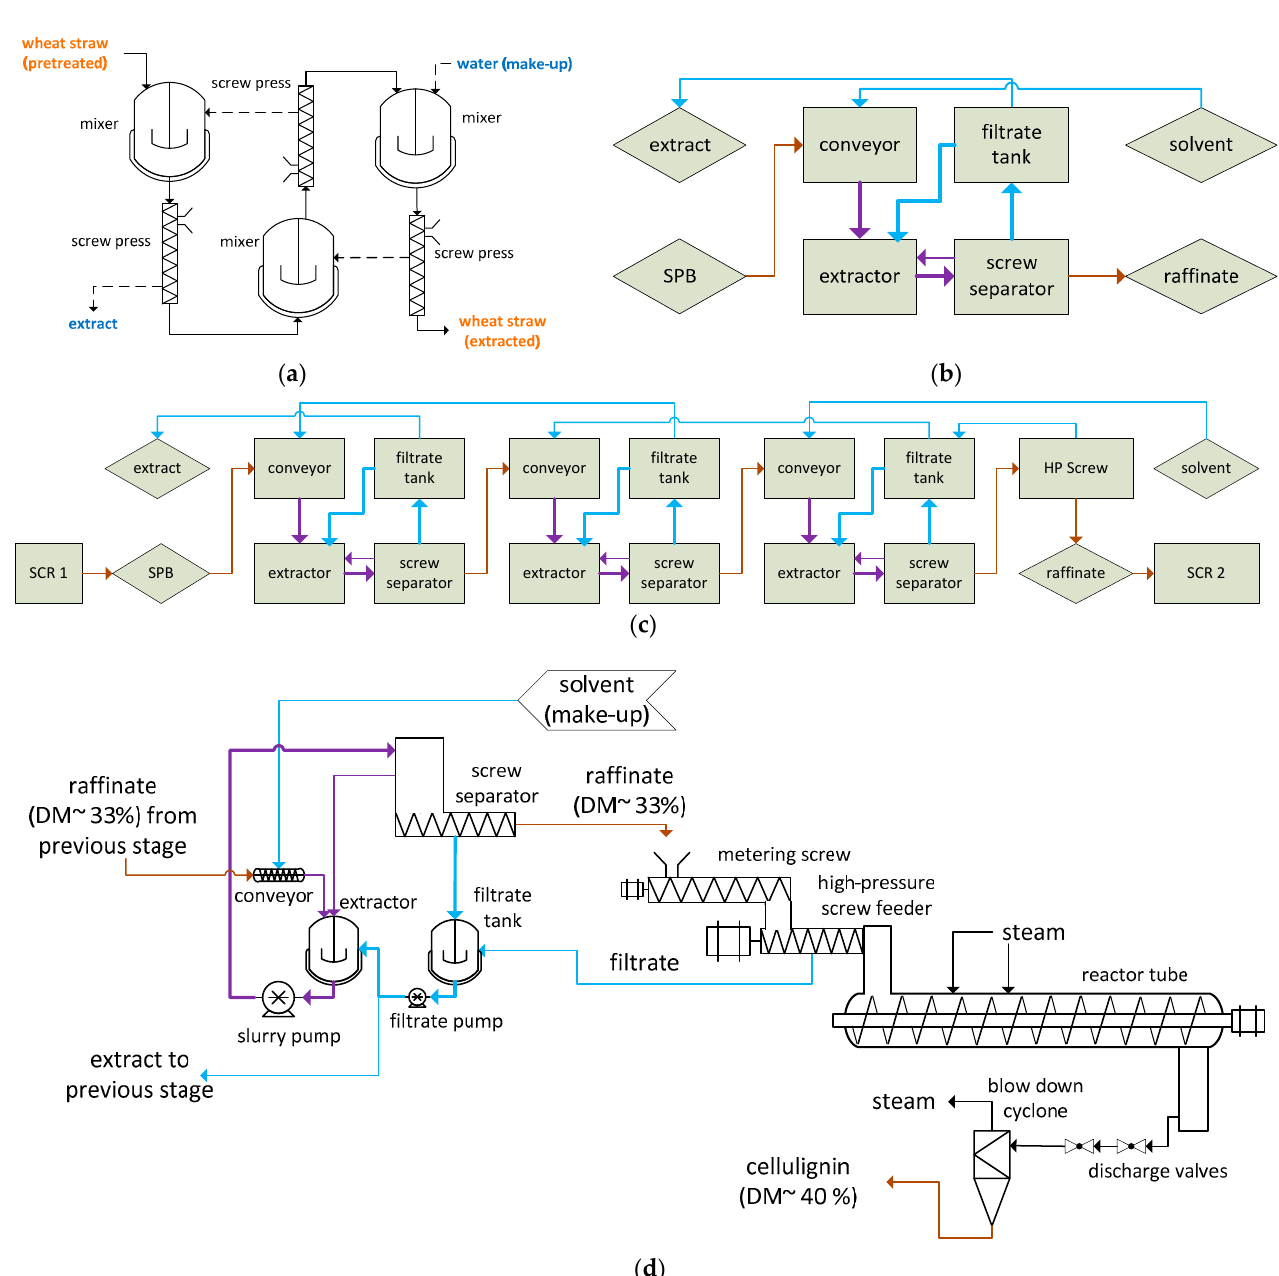
Figure 2. Proposed counter-current solid-liquid extraction process for lignocellulosic material ( a ) Simplified process scheme of the proposed counter-current solids-liquid extraction process with three stages for the case of pretended wheat straw leaching. Alternating mixing and dewatering units, shown as screw presses, for solid and fluid flow. Solid containing stream (solid arrows). Mainly solid free stream (dashed arrows). ( b ) Block flow diagram of a single stage of the new counter-current extraction process. Diamonds represent overall input and output flows; steam pretreated biomass (SPB), raffinate, solvent, and extract. Rectangles represent the units of each stage, conveyor (optional) with initial mixing of moist solids and solvent, extractor as a continuous stirred tank, screw separator as mechanical dewatering device, and filtrate tank. Recycle streams are overflow from the screw press feed tank (not shown) back to the extractor and fluid from the filtrate tank to the extractor. ( c ) Block flow diagram of counter-current solid-liquid extraction with three stages for the usage as leaching process of steam pretreated biomass (SPB). Integration into a two-step autohydrolysis concept, including two screw conveyor reactors (SCR). ( d ) Graphic representation of the counter-current solids extraction integrated into the subsequent HP screw of the screw conveyor reactor.